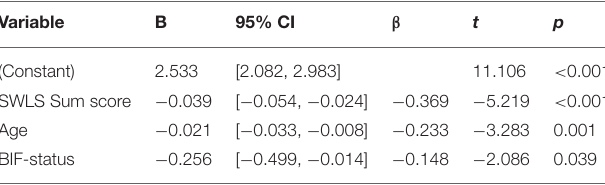
TABLE 3 | Summary of the regression analysis with SCL-90-R GSI as dependent and BIF status, age, and SWLS sum as independent variables.